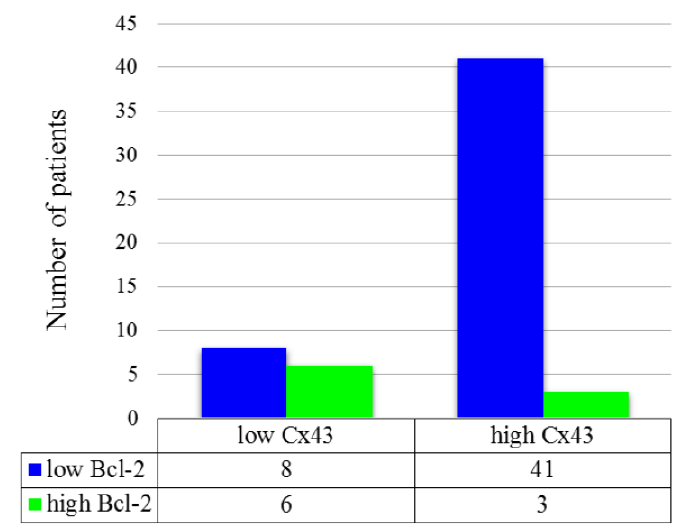
Figure 8. Distribution of patients according to Cx43 and Bcl-2 immunohistochemistry. Groups were compared by Fisher’s exact test ( p = 0.013).